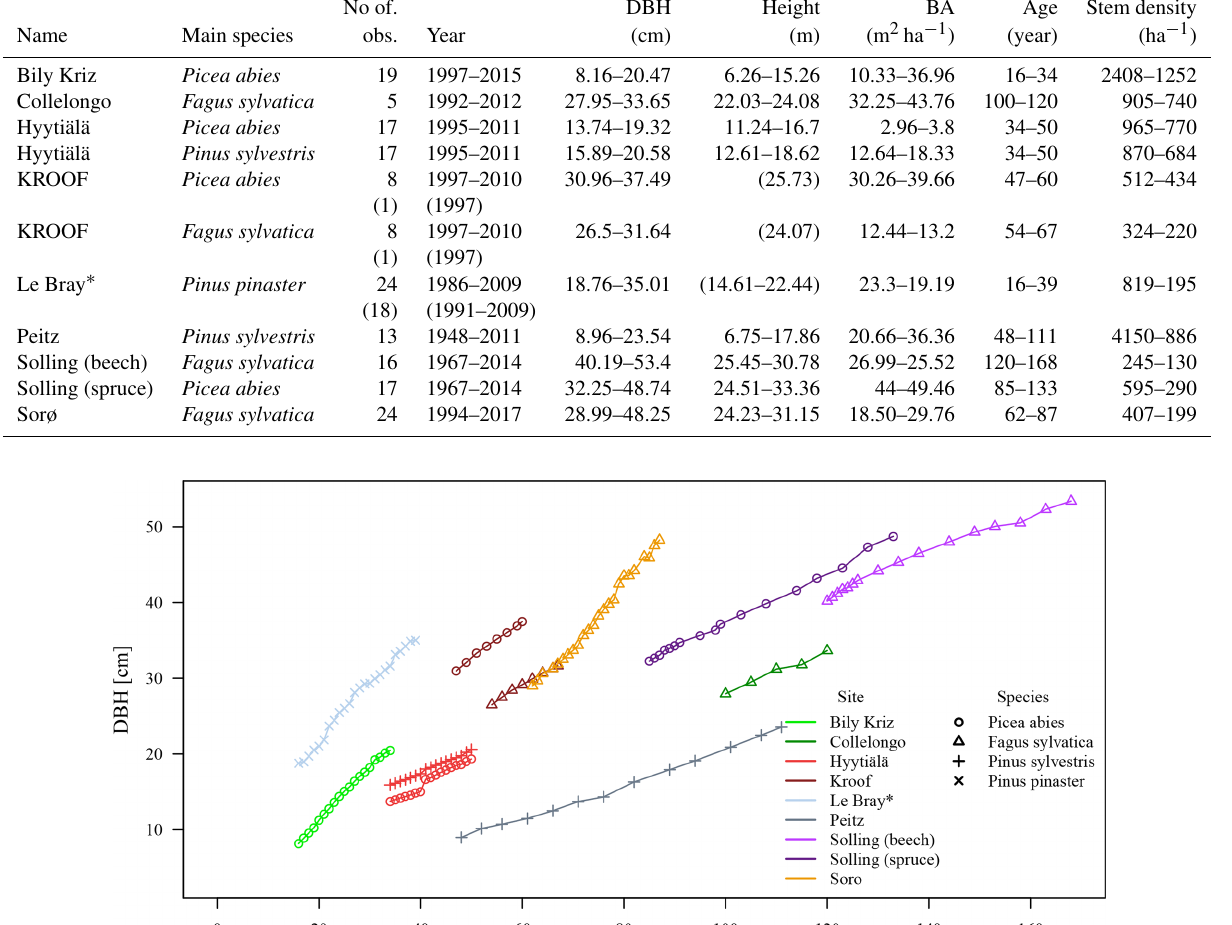
Figure 6. Time series of tree diameter at breast height (DBH) versus age of the forest stands in the PROFOUND DB. The basal area-weighted mean DBH is shown for all stands with the exception of Le Bray for which the arithmetic mean DBH is shown (marked by asterisks). For Sorø, the DBHs have been reconstructed (see text in Sects. 4.9 and S1).